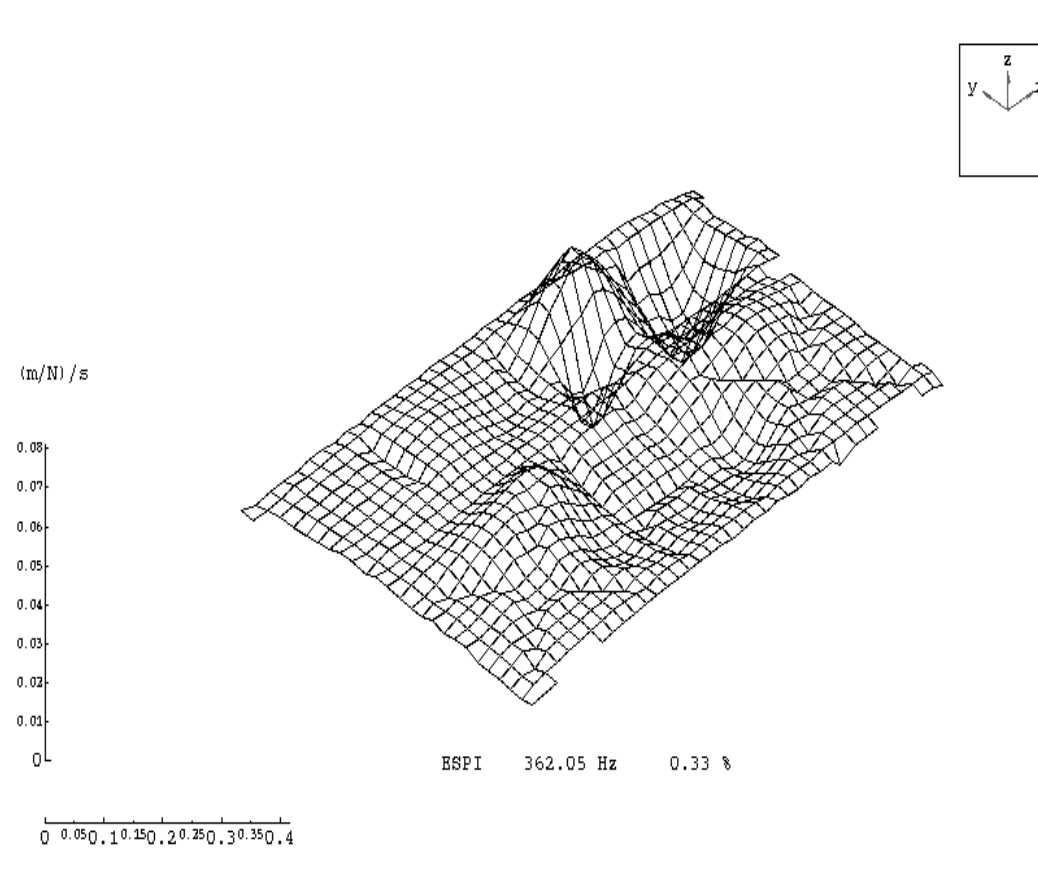
Fig. 11. Mode at 362.05 Hz